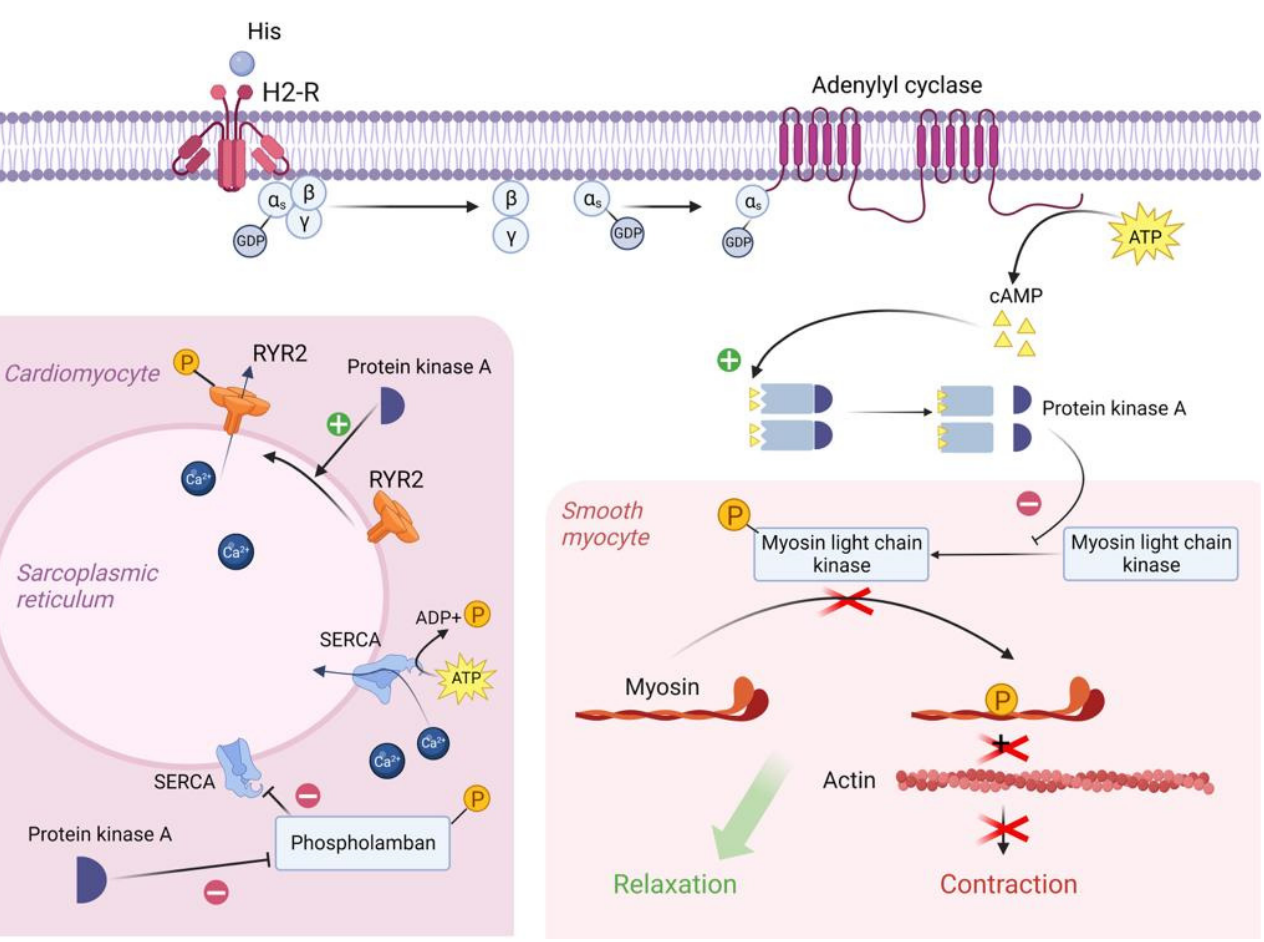
Figure 2. Molecular mechanism of H2 receptor activation by exogenous histamine in SFP. Exogenous histamine binds to the H2-R and leads to the adenylyl cyclase system activation. In smooth muscle cells, PKA phosphorylates MLCK, leading to the smooth muscle cell relaxation. In cardiomyocytes, PKA phosphorylates Phospholamban and RYR2, resulting in an increased heart rate. PKA— proteinkinase A, GTP—guanosine triphosphate, MLCK—myosin light chain kinase, GDP—guanosine diphosphate, cAMP—cyclic adenosine monophosphate, RYR2—ryanodine receptor 2, SR— sarcoplasmic reticulum, SERCA—sarco/endoplasmic reticulum Ca—ATPase.